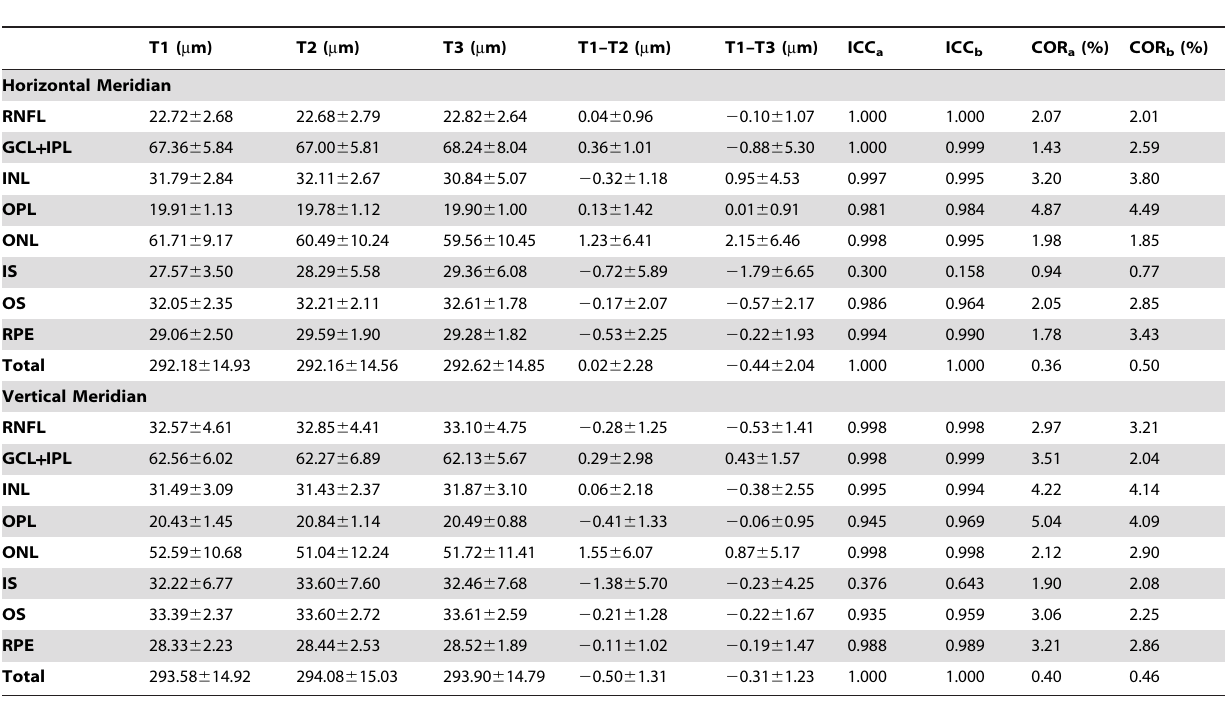
Figure 5. Segmentation errors in scans of lower image quality and corresponding corrected segmentation after applying the semi- automated approach. (A) The algorithm mistakenly identified the OPL/ONL interface. (B) Corrected segmentation corresponding (A) after applying the semi-automated approach. (C) The algorithm mistakenly identified the RNFL/GCL boundary. (D) Corrected segmentation corresponding (C) after applying the semi-automated approach. doi:10.1371/journal.pone.0087996.g005 layers thicknesses ranged from 19.85 to 67.18 m m with UHR- UHR-OCT and RTVue100, respectively. There were no OCT and 20.88 to 72.03 m m with the RTVue100. significant differences between the two thickness measurements for either instrument obtained by the same examiner. The ICCs Table 2 and Table 3 show the repeatability and reproducibility obtained for the intra-observer repeatability and inter-observer of thickness measurements for intra-retinal layers measured with Table 2. Repeatability and reproducibility of thickness measurements for intra-retinal layers measured by